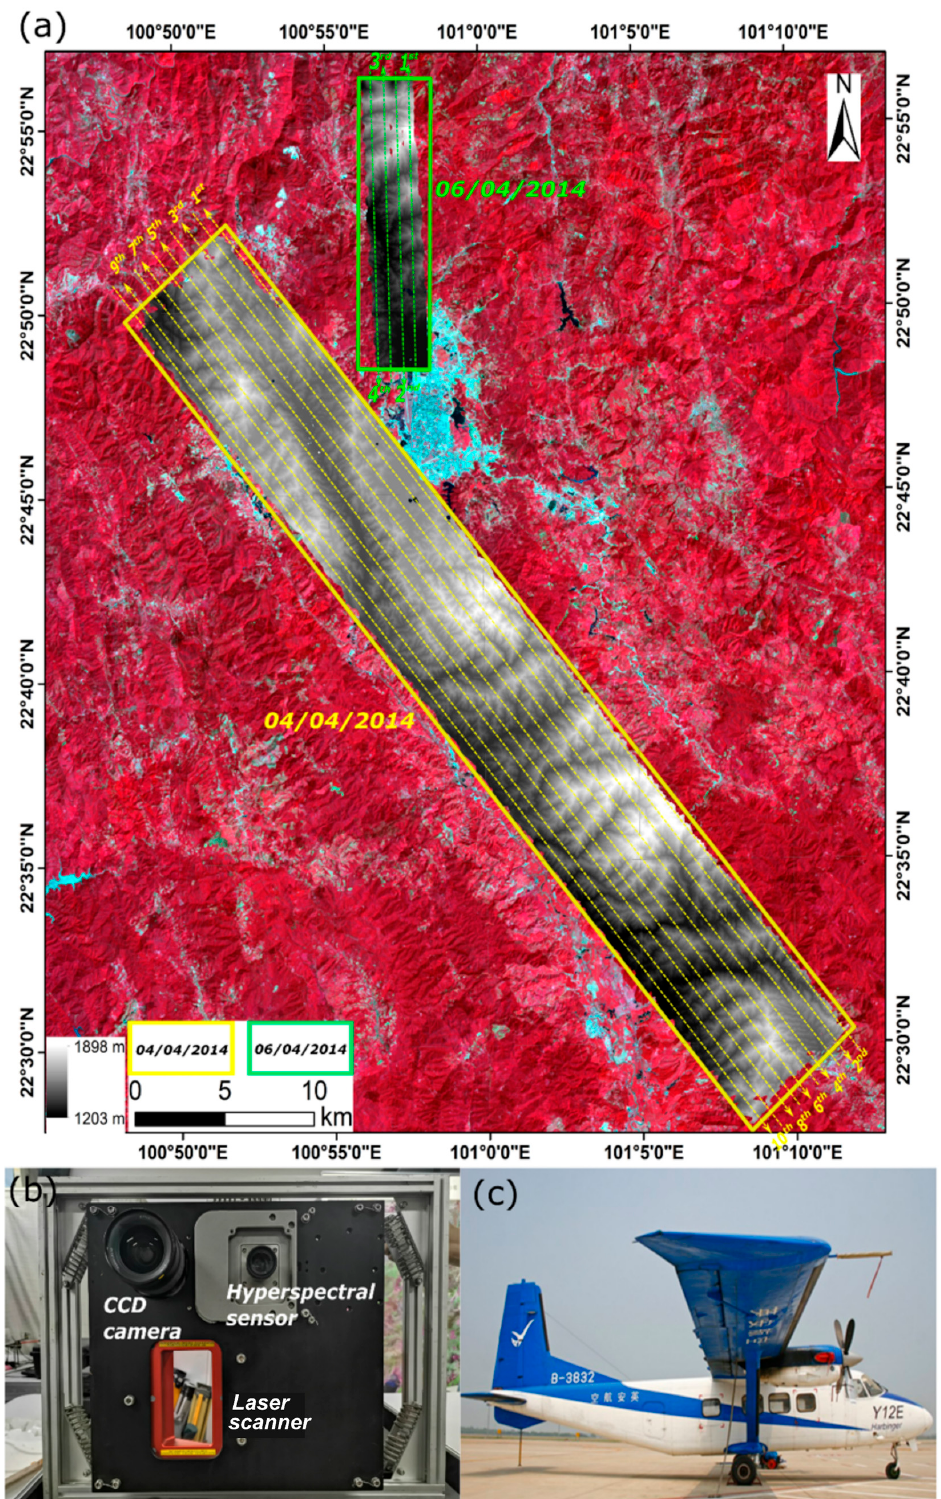
Figure 1. ( a ) Location of the study area and schematic map of the 04 April 2014 (yellow) and 06 April 2014 (green) flight-lines overlying the 14 April 2014 false-color Landsat 8 OLI image (path / row = 130 / 044, bands 5, 4, 3) and airborne LiDAR-derived digital elevation model (DEM). ( b ) The CAF-LiCHy airborne system flown on the ( c ) Harbin Y-12E aircraft.